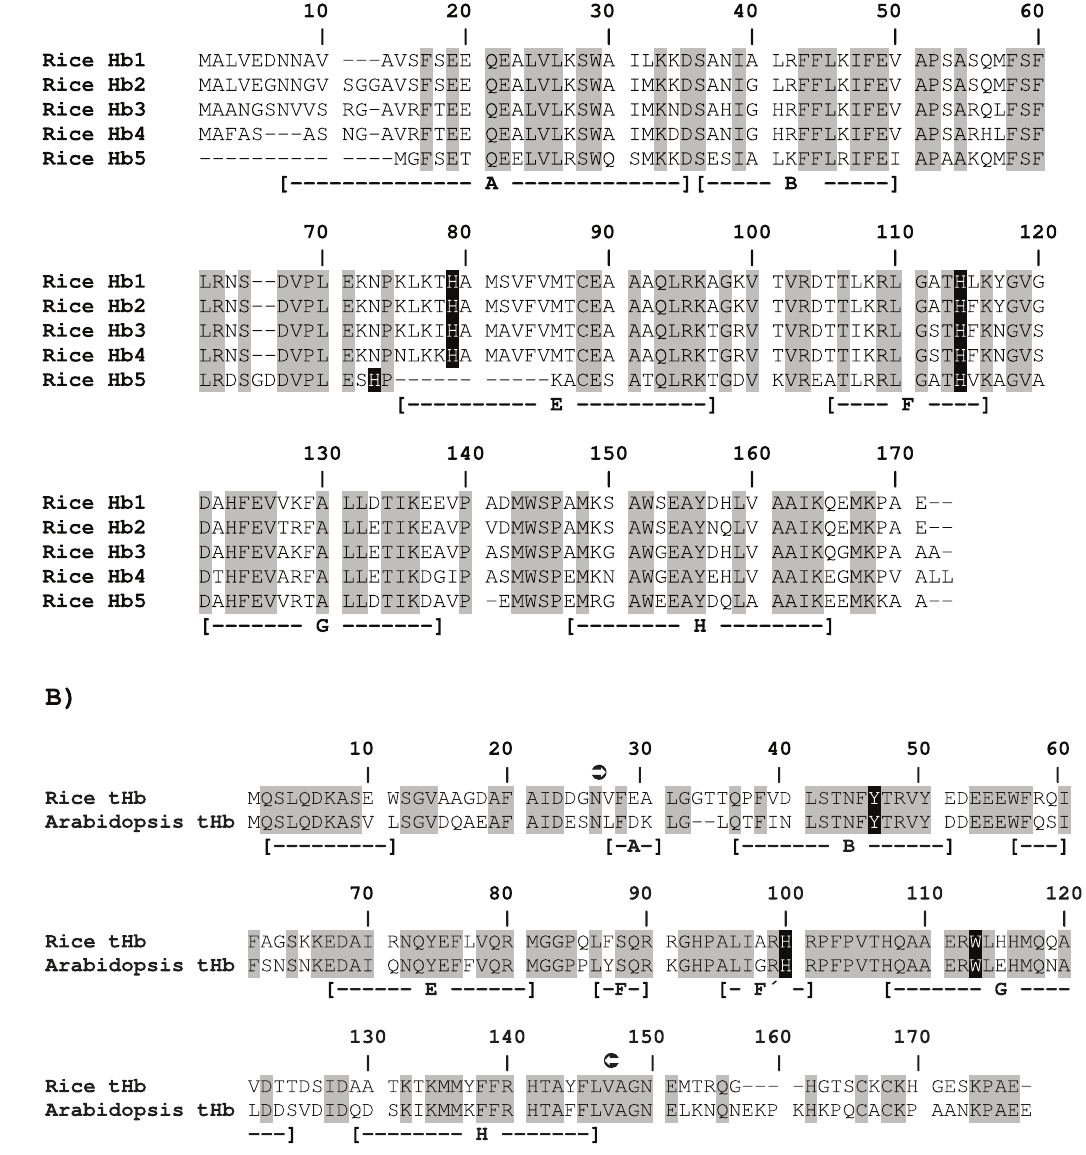
Figure 3. Sequence alignment of rice Hbs. ( A ) Sequence alignment of rice nsHbs. Note the 11 amino acids deletion in rice Hb5 at position 75–85. Modified from Garrocho-Villegas et al . 62 . ( B ) Sequence alignment of rice and Arabidopsis (GenBank accession number AAK55409) tHbs. Distal and proximal His in rice nsHbs (H79 and H114, respectively) and proximal His (H100) and proposed distal Tyr/Tre (Y46/W113) in Arabidopsis 86 and rice tHbs and conserved amino acids are shown with black and gray background, respectively. Helices are indicated with letters A to H based on the crystal structure of rice Hb1 71 in rice nsHbs and on the crystal structure of Arabidopsis tHb 86 in rice tHb. Left- and right-oriented arrows within a black circle in the rice and Arabidopsis tHbs sequence alignment delimit the globin